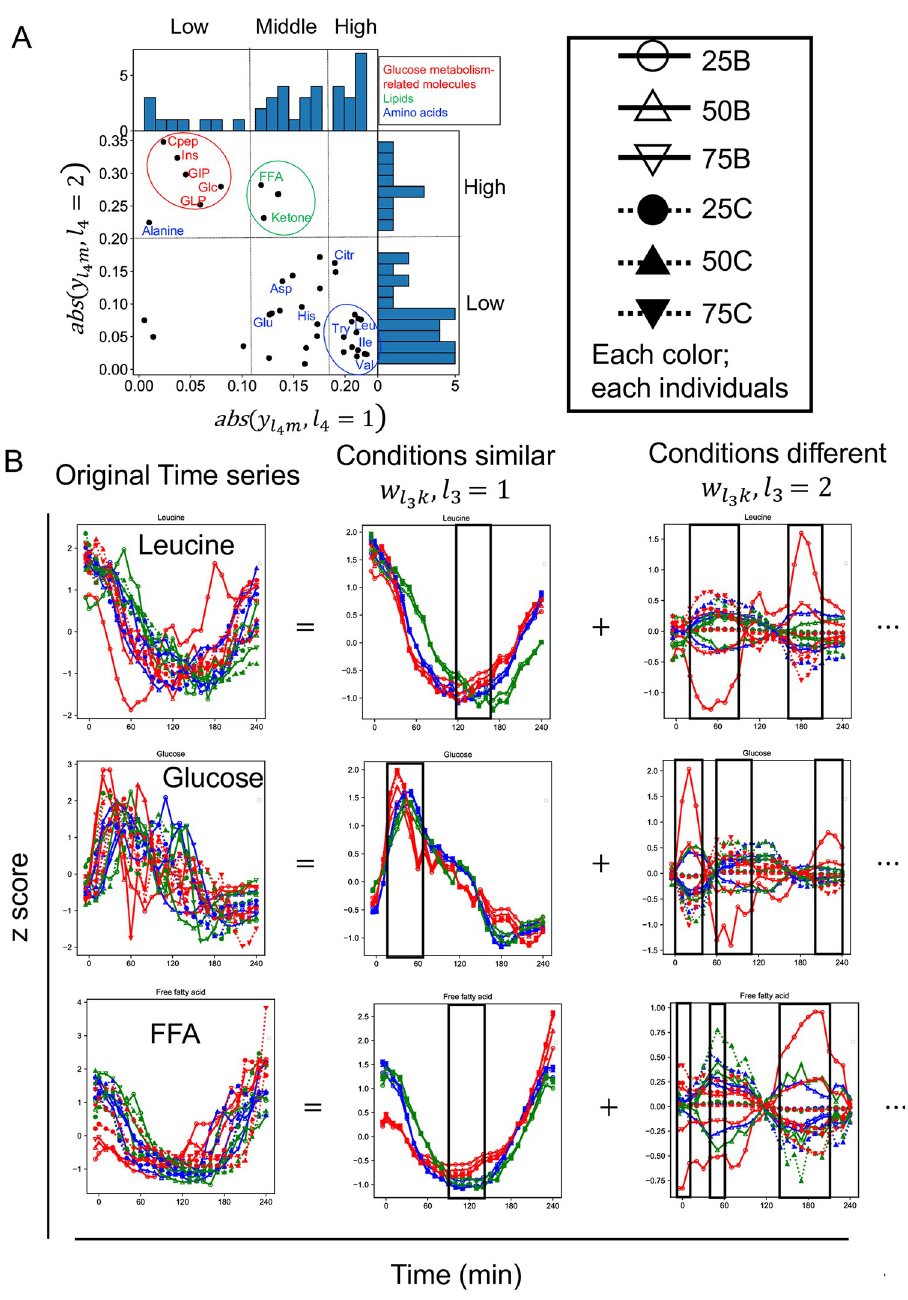
Fig 7. The individual-related singular vectors and decomposed time series by the dominant singular vectors (‘ fourth-order tensor with individuals mode , time mode , experimental condition mode and molecule mode ’). A The molecule-related singular vectors ( y ; l ¼ 1 ; 2 ). The dashed lines show the values of y ; l ¼ 1 divided into three, 4 4 l 4 m l 4 m and y ; l ¼ 2 divided into two, based on the shape of the distribution. B Decomposed time series by the dominant 4 l 4 m singular vectors of a representative molecule and the original time series. Decomposed time series by other than the dominant singular vectors ( w ; l > 2 ) are omitted. The black lines in “conditions similar” indicate the time point of 3 l 3 k the peak. The black boxes and the black lines in “conditions different” indicate the time points of high variability among conditions. The color of each line indicates each condition. Solid lines indicate bolus ingestion, and dahed lines indicate 2 h continuous ingestion. Circles, triangles, and lower triangles indicate the three doses, 25, 50, and 75 g, respectively. Abbreviations for the representative molecules are as follows: Asp aspartic acid; Cit, citrulline; CRP, C- reactive peptide; FFA, free fatty acid; 3-OH, 3-hydroxybutyric acid; Ketone, Total ketone body; GIP, gastric inhibitory polypeptide (active); Glc, glucose; GLP, glucagon-like peptide-1; Glu, glutamic acid; His, histidine; Ile, isoleucine; Ins, insulin; Leu, leucine; Tyr, tyrosine; Val, valine. The label colors correspond to the metabolic group list (inset).